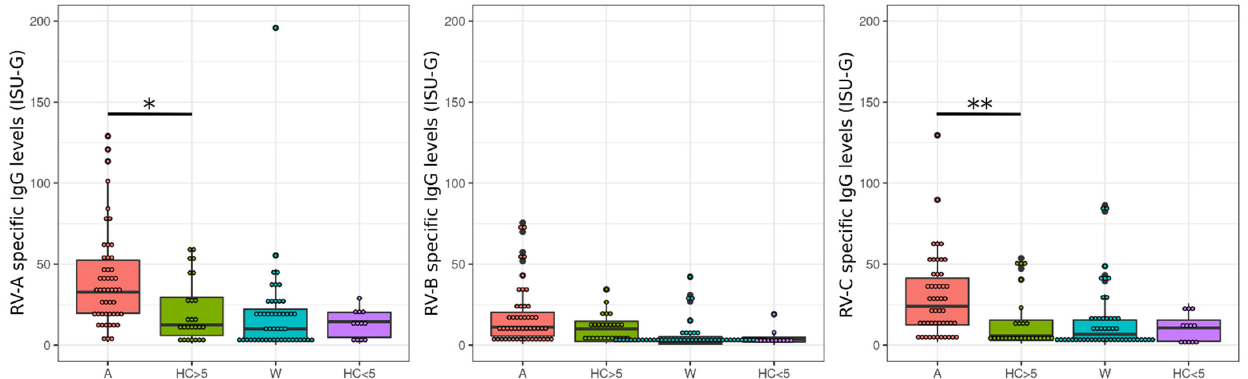
Figure 1. Rhinovirus (RV) species-specific A- and C-IgG levels are higher in asthmatics than in age-matched controls. Exacerbated asthmatics and wheezers were compared with age-matched controls for their species-specific anti-RV-IgG levels, expressed as ISAC standardized units (ISU-G). Results are displayed as box plots, where 50% of the values are within the boxes and non-outliers between the bars. Lines within boxes indicate median values. Here, exacerbated asthmatics revealed higher IgG level of RV-A and -C than healthy controls. The groups were compared using Mann–Whitney-U tests. The p -values were corrected using the FDR method. Significant differences were observed between asthmatics and age-matched healthy controls for A species ( p = 0.011) and C species ( p = 0.0051). *: 0.01 < p < 0.05; **: 0.001 < p < 0.01. A: Asthmatics, HC > 5: Healthy controls five years old or older, W: Wheezers, HC < 5: Healthy controls younger than five years old.